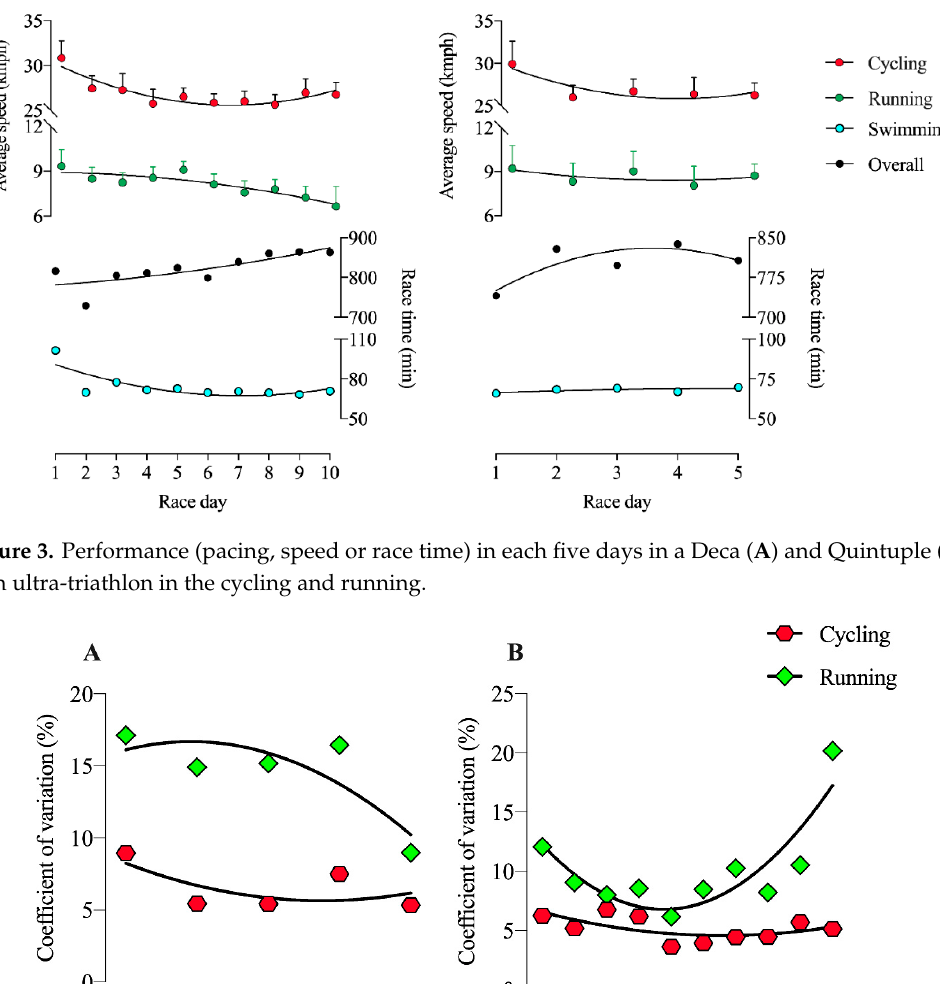
Figure 2. Pacing in each of the ten days in a Deca Iron ultra ‐ triathlon in the cycling ( A ) and running ( B ) split.